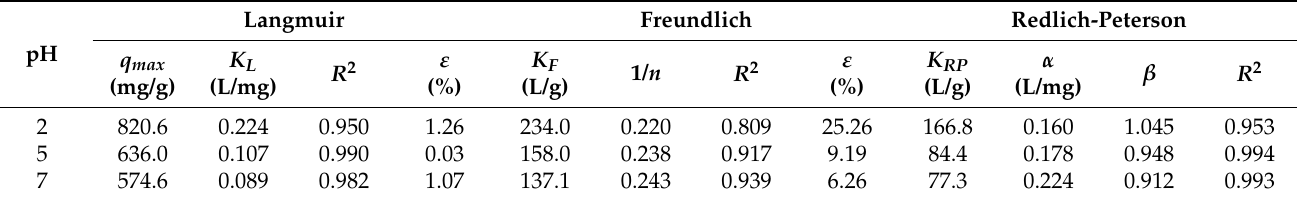
Table 2. The parameters of the isotherm models for RY2 adsorption onto PEI/PVC-CF. Langmuir Freundlich Redlich-Peterson pH